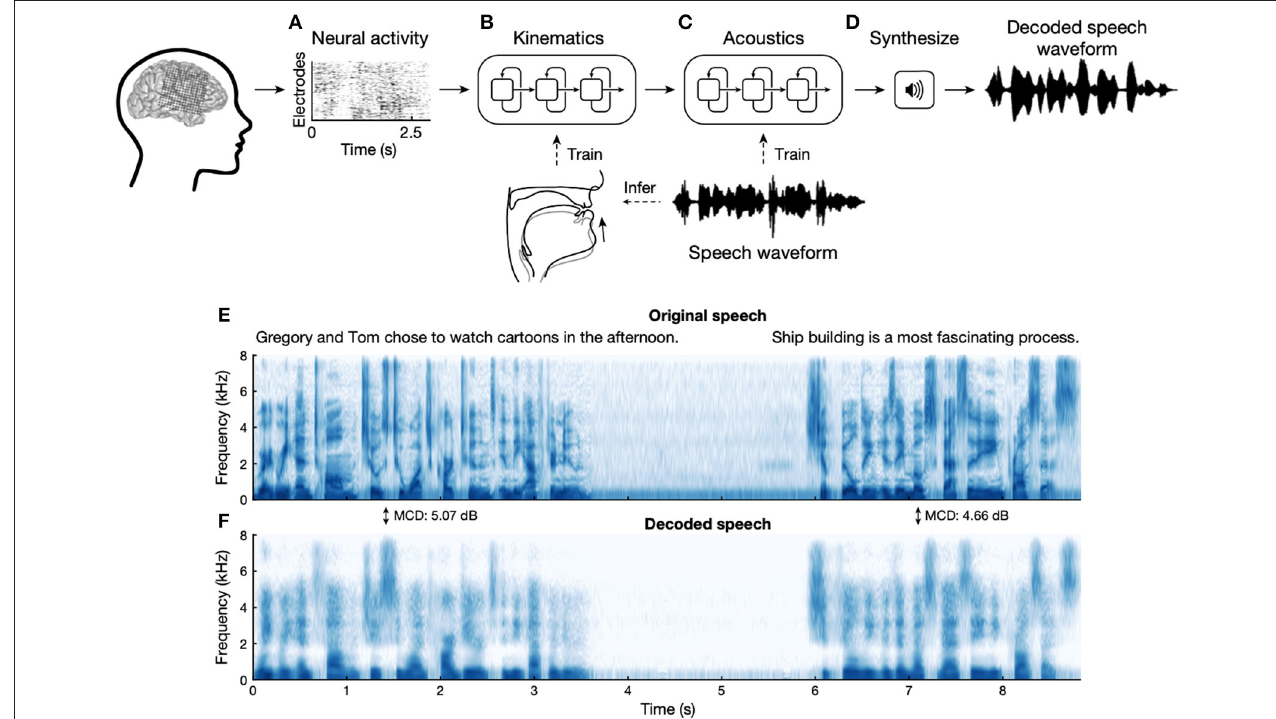
FIGURE 3 | Speech synthesis from recorded electrocorticogram during spoken sentences. (A) The neural decoding process begins by extracting relevant signal features from high-density cortical activity. (B) A neural network decodes kinematic representations of articulation from ECoG signals. (C) An additional algorithm decodes acoustics from the previously decoded kinematics. Acoustics are spectral features extracted from the speech waveform. (D) Decoded signals are then synthesized into an acoustic waveform. (E) Spectrogram shows the frequency content of two sentences spoken by a participant. (F) Spectrogram of synthesized speech from brain signals recorded simultaneously with the speech in (E) . From Anumanchipalli et al.